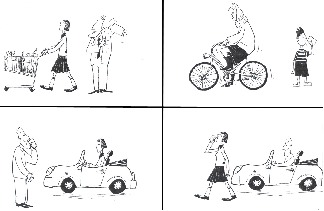
Example of a trial in the sentence comprehension (SC) task, with the four images displayed on the individual tablets. The spoken sentence was “The man drives the car and the woman drinks the milk.”